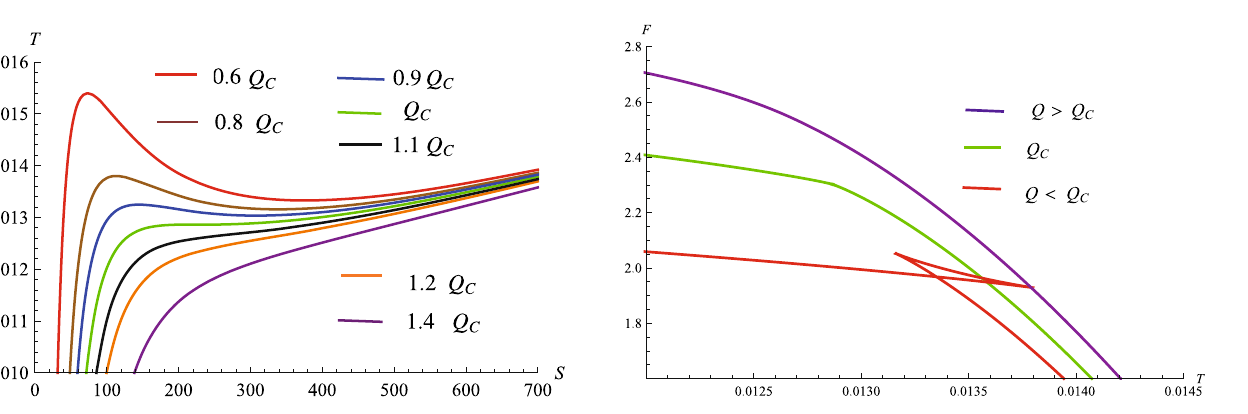
Fig. 3 The relationship between temperature T versus the free energy F for varying Q for the case α = 1 and l = 20 for charged Gauss– Bonnet AdS black hole in four